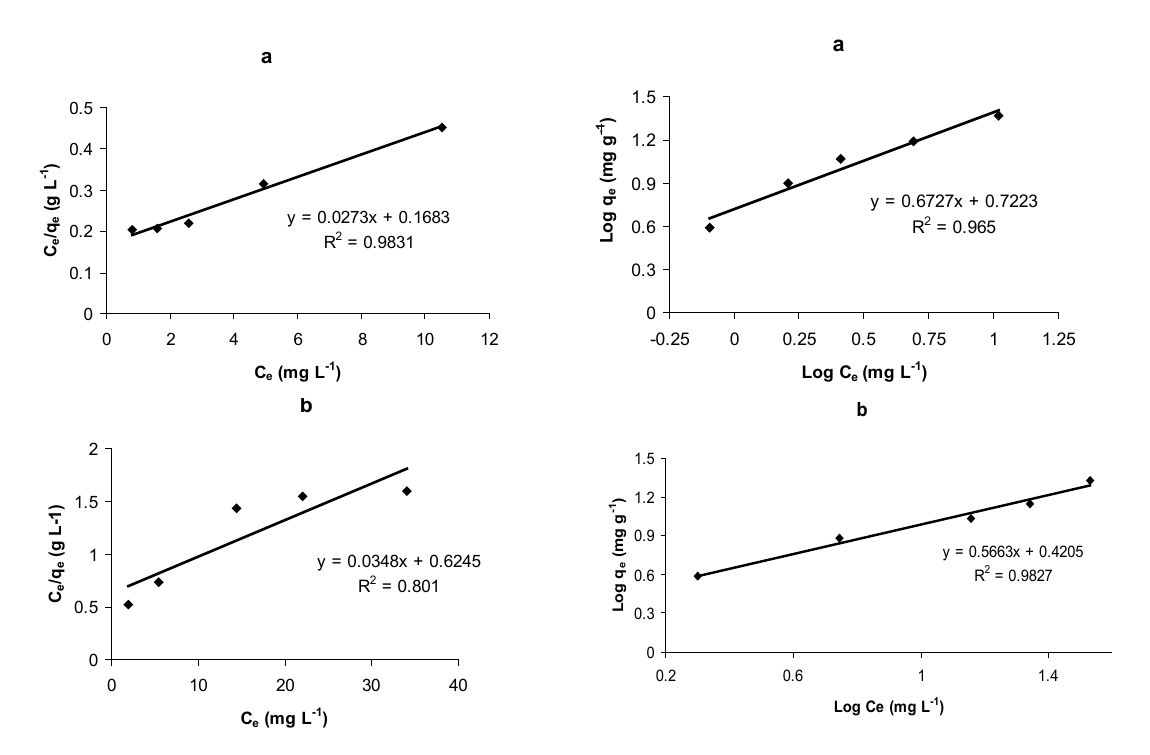
Figure 7. Frunlich adsorption isotherms of Pb(II) ions onto (a) PASAC and (b) ZASAC at room